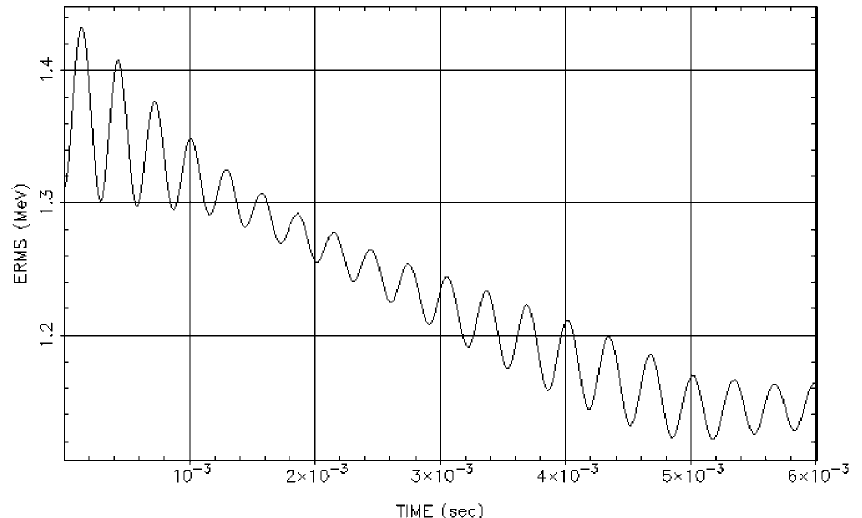
FIG. 4. The same conditions used for Fig. 3 except scaled with l (cid:1) 2 . Note that the time scale is t 0 (cid:1) t (cid:3) l , one-half of that